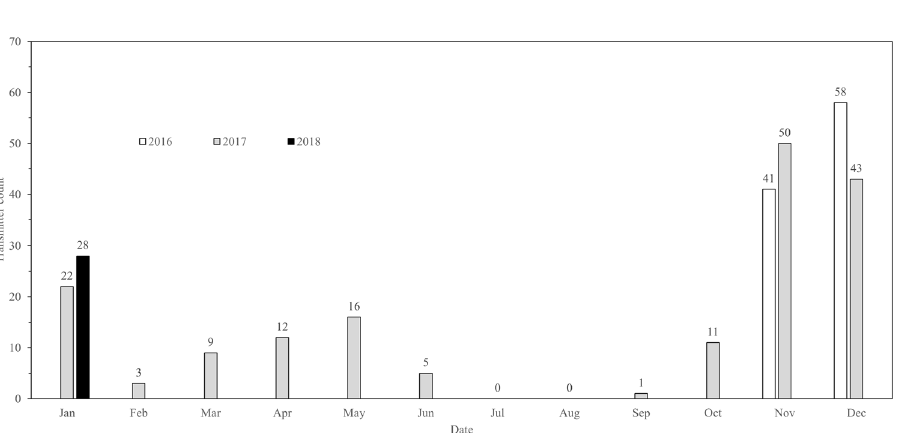
Figure 2. Detection count (top panel) and unique transmitter count (bottom panel) of Atlantic Sturgeon detected on acoustic transceivers in the New York Wind Energy Area study site (Equinor, Lease OCS-A 0512). Transceivers are represented by increasing distance from shore; note that intervals are not equal.